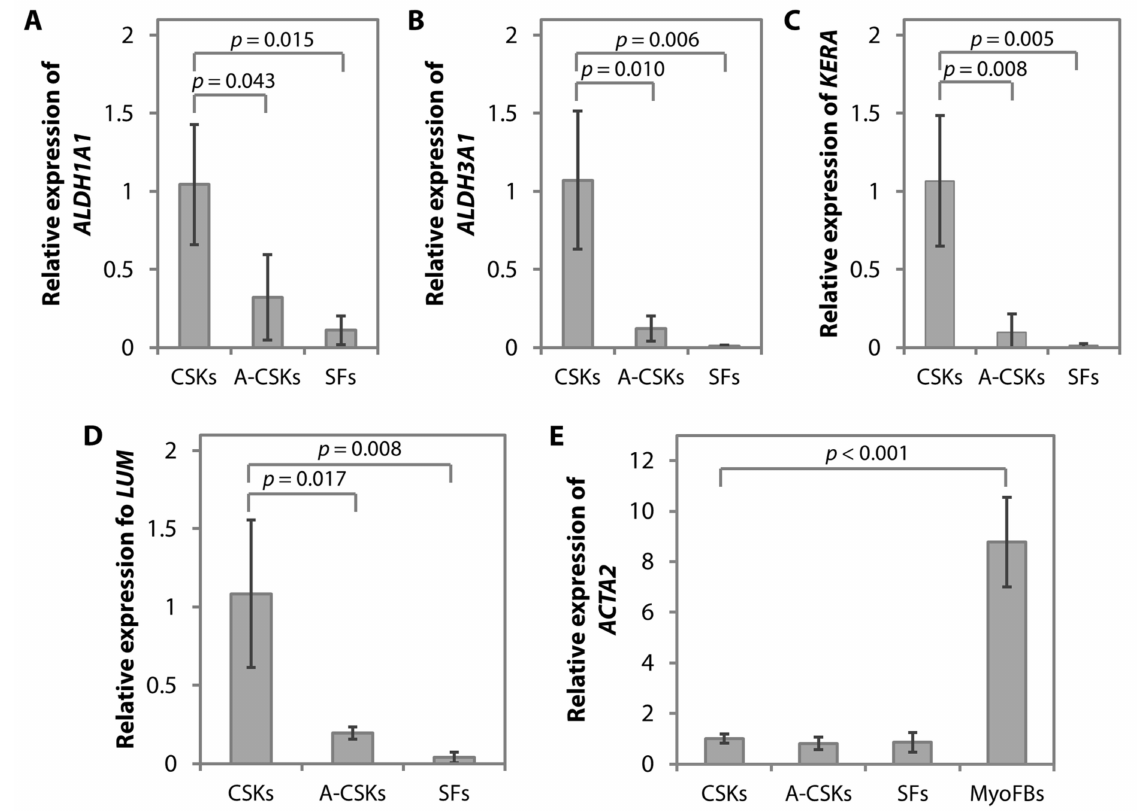
Figure 6. Gene expression of corneal stromal keratocytes (CSKs), activated CSKs (A-CSKs), and corneal fibroblasts (SFs). The gene expression was detected using real time-polymerase chain reac- tion. Similar to the protein expression, CSK-associated genes, such as ALDH1A1 ( A ), ALDH3A1 ( B ), KERA ( C ), and LUM ( D ) were strongly expressed in the CSKs following 14 days of culture media switching to serum-free conditions and were significantly upregulated when compared to the A-CSKs and SFs. ( E ) The corneal stromal myofibroblast (MyoFB)-associated gene, ACTA2 , was significantly downregulated in the CSKs, A-CSKs, and SFs compared to the MyoFBs. For the analysis of differen- tially expressed genes, CSKs was used as the reference group for comparison, whereas GAPDH was used as the housekeeping gene. Group comparisons were statistically determined using one-way ANOVA and Tukey comparison